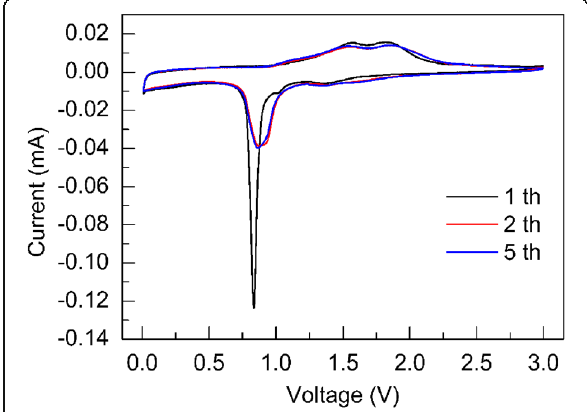
Fig. 3 Cyclic voltammetry curves of the nanocrystalline Fe 2 O 3 film. The curves were measured at a scan rate of 0.1 mV s − 1 from 0.01 to 3 V